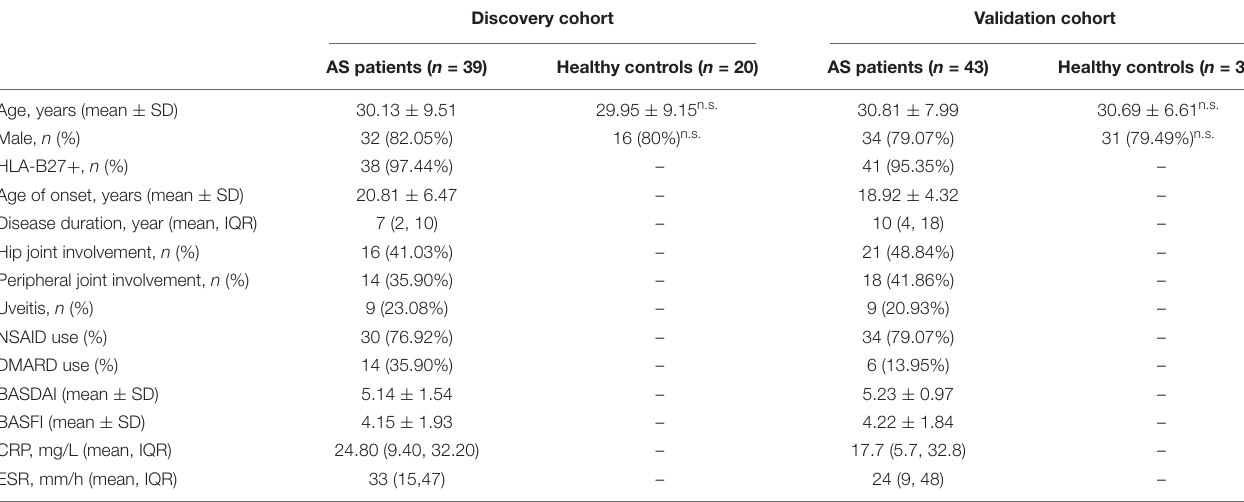
TABLE 1 | Clinical characteristics of the study population.